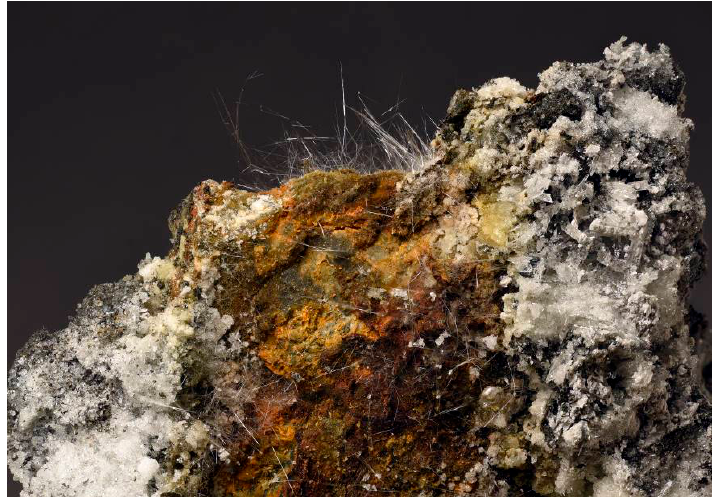
Figure 9. Epsomite from the Fornovolasco mine as hairy acicular crystals, up to 2 cm long, and microcrystalline sugary colorless aggregates.